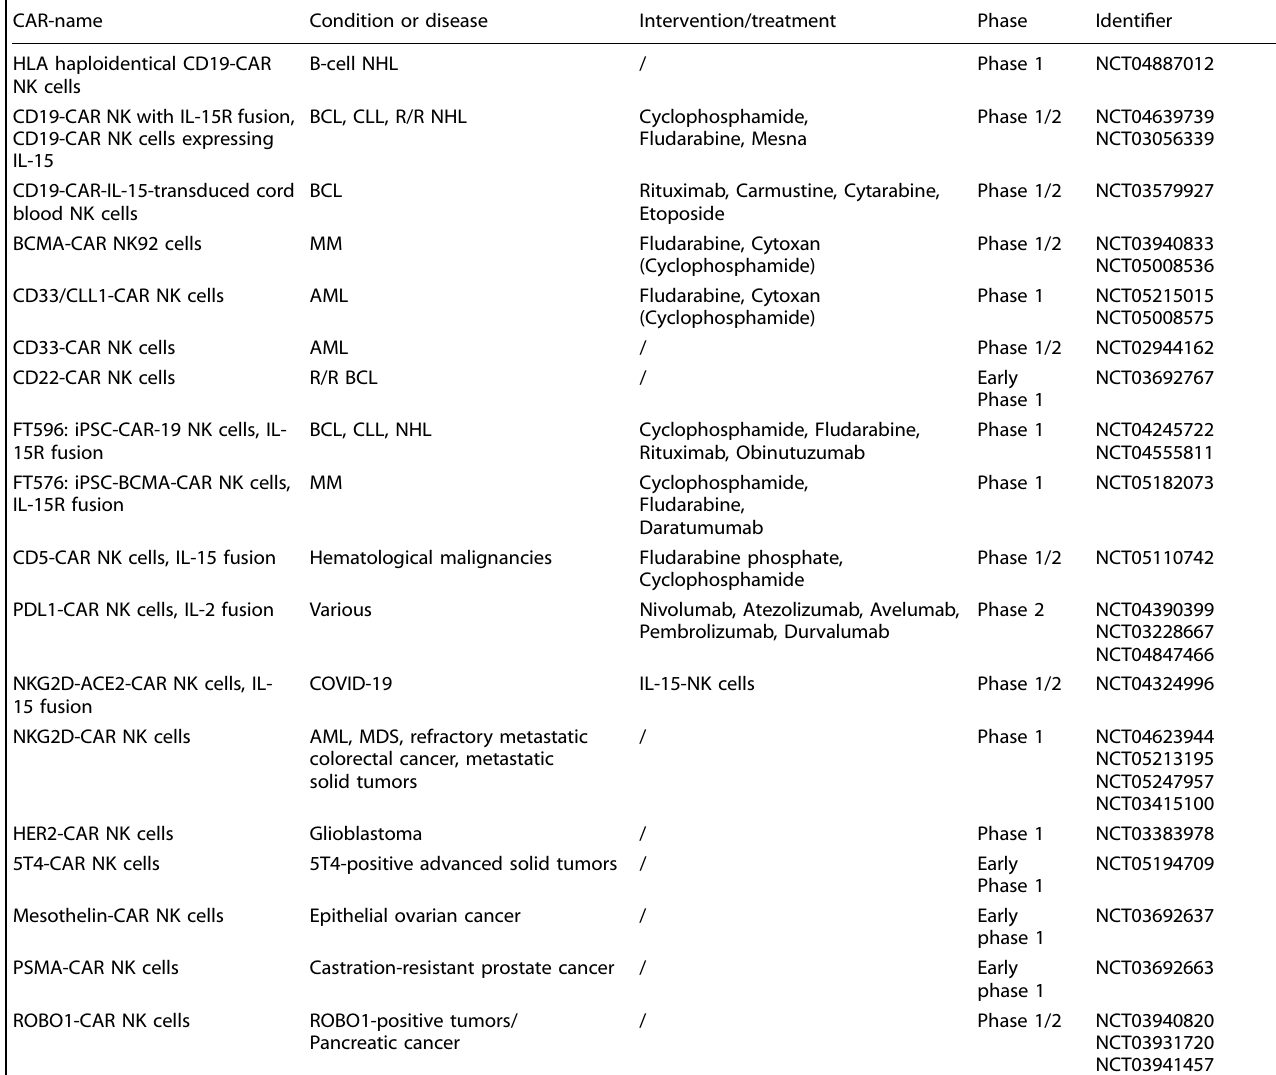
Table 3. Ongoing clinical trials related to CAR-NK cells